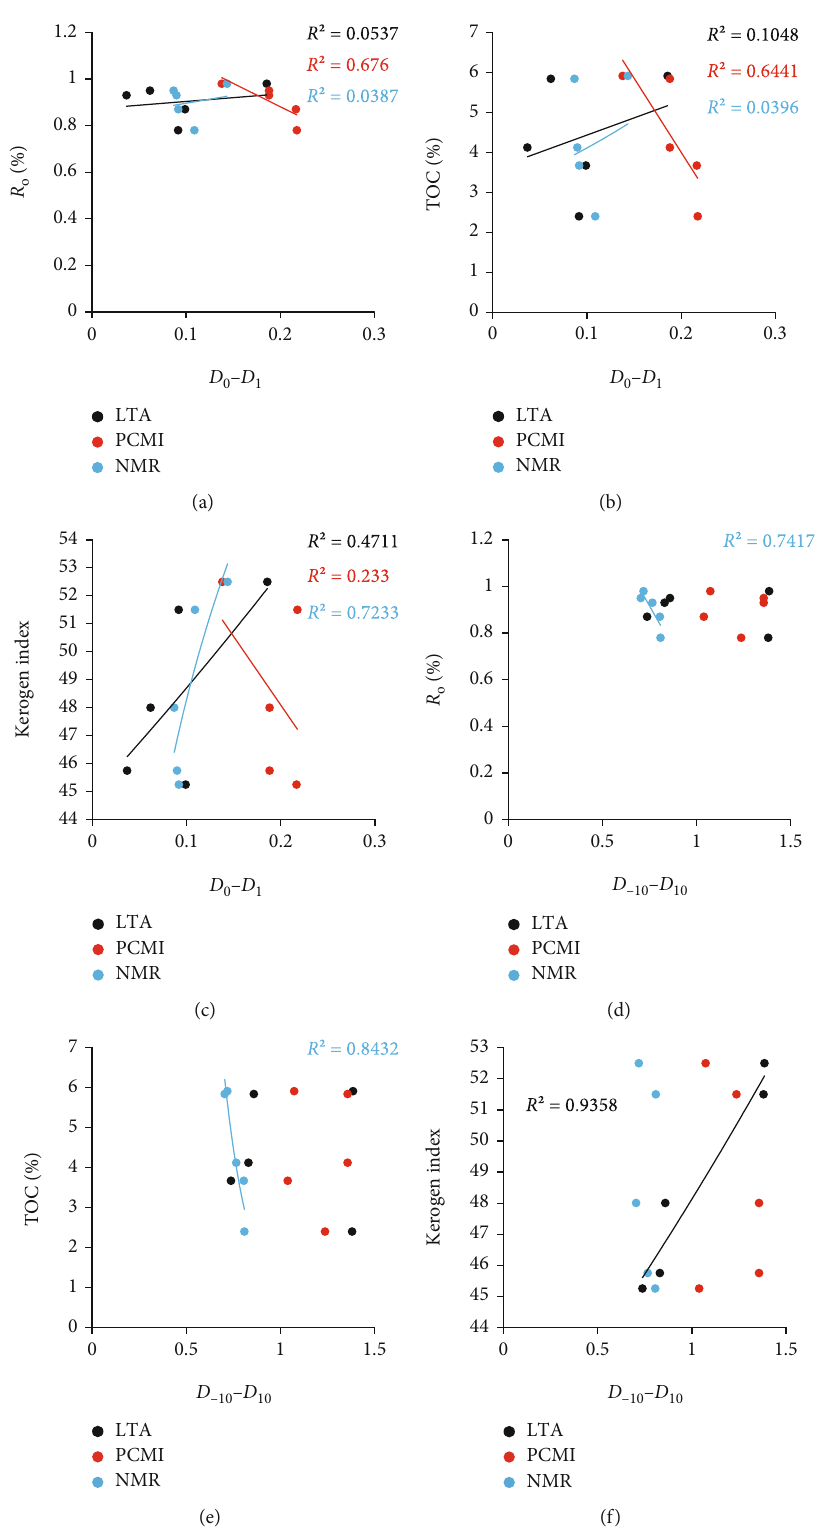
Figure 11: The impact on multifractal parameter from geochemical parameters: D - D vs. (d) average R and D − 10 10